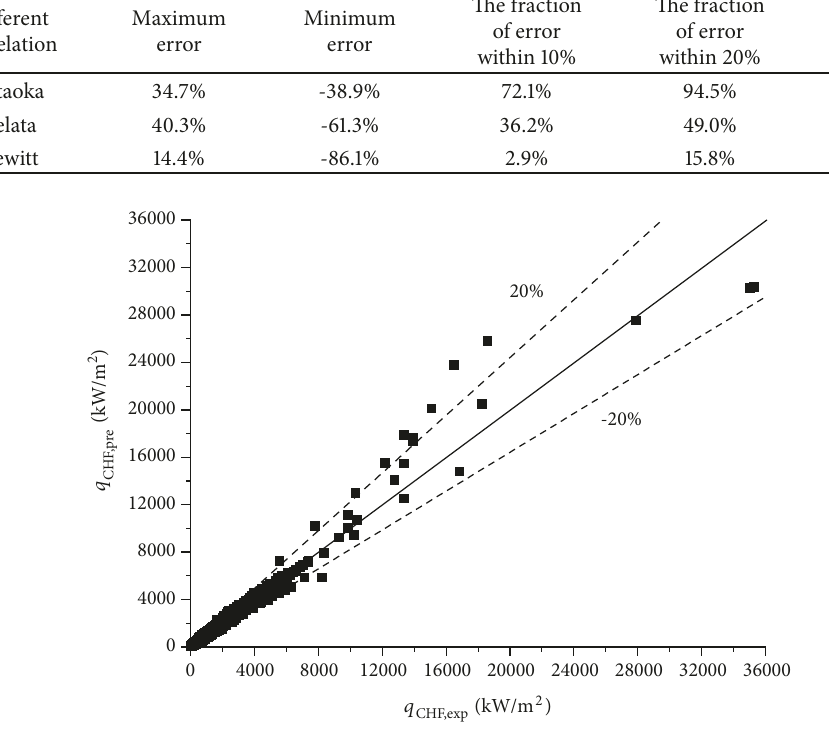
Figure 6: Predicted CHF as a function of measured